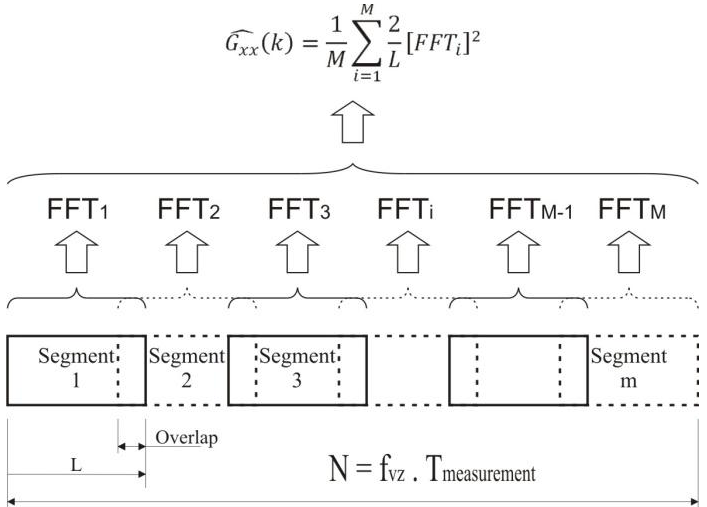
Figure 7 . Welch‘s method of modified